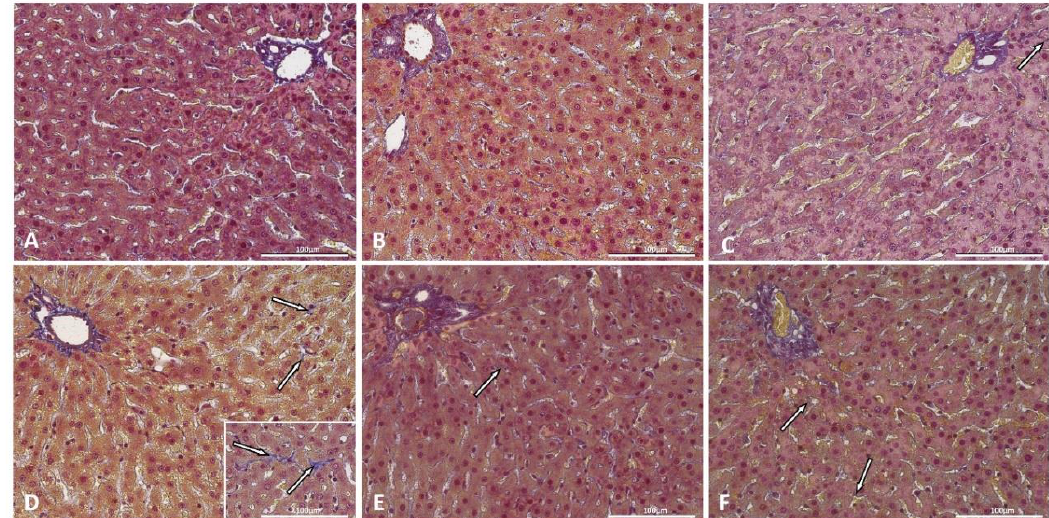
Figure 3. Liver sections from a representative rat from each group: ( A ): control; ( B ): control supplemented with TT saponins; ( C ): control supplemented with TT saponins plus inulin; ( D ): with induced diabetes mellitus; ( E ): with induced diabetes mellitus supplemented with TT saponins; ( F ): with induced diabetes mellitus supplemented with TT saponins plus inulin. Arrows indicate fibrotic changes. Mallory’s trichrome method × 40. Scale bar: 100 µm. Table 1. Scores of hepatic steatosis and hepatic fibrosis staging. Histological Grades of Steatosis Number of Evaluated Histological Fields Group N (n)